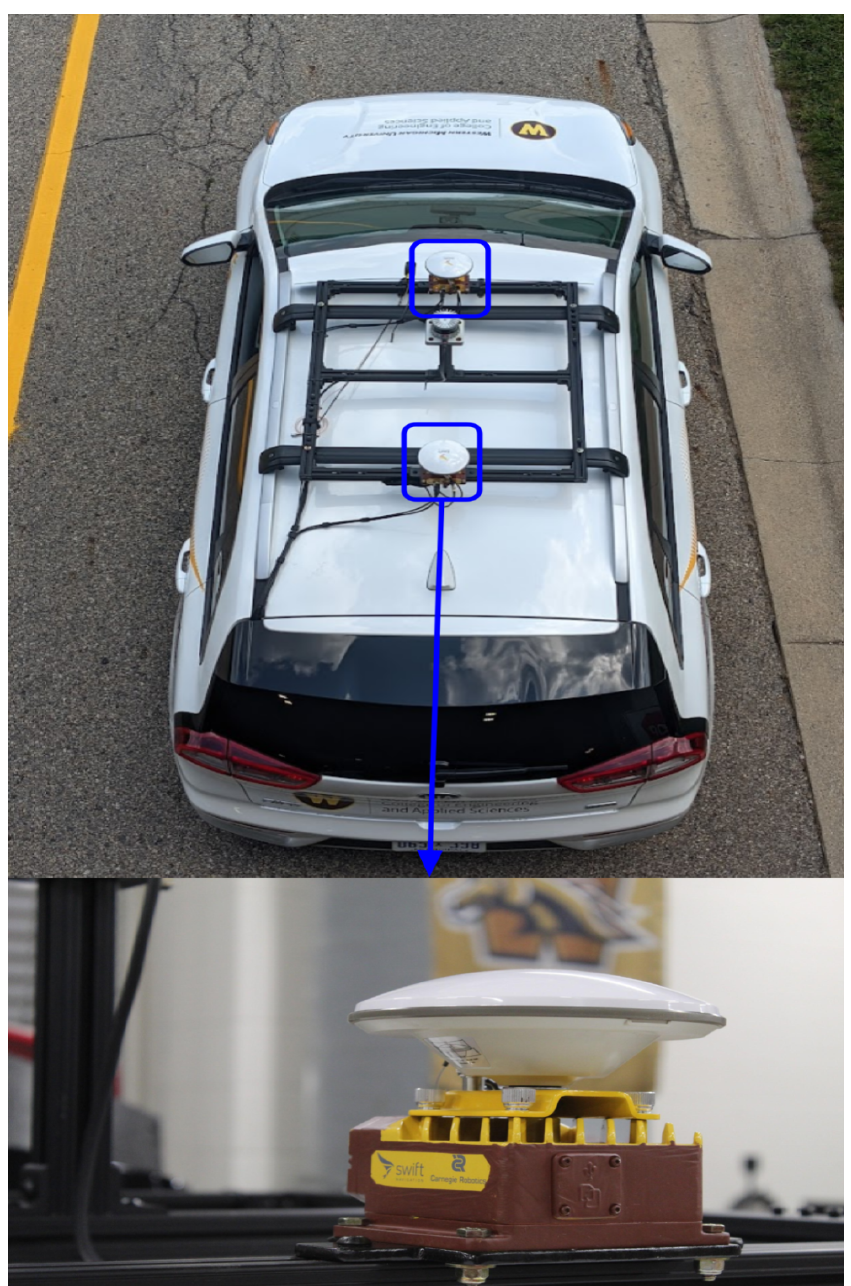
Figure 9. One of the Swift Navigation Duro sensors fitted onto the roof’s mounting rack (painted) with the offset of the heading configuration is set to zero